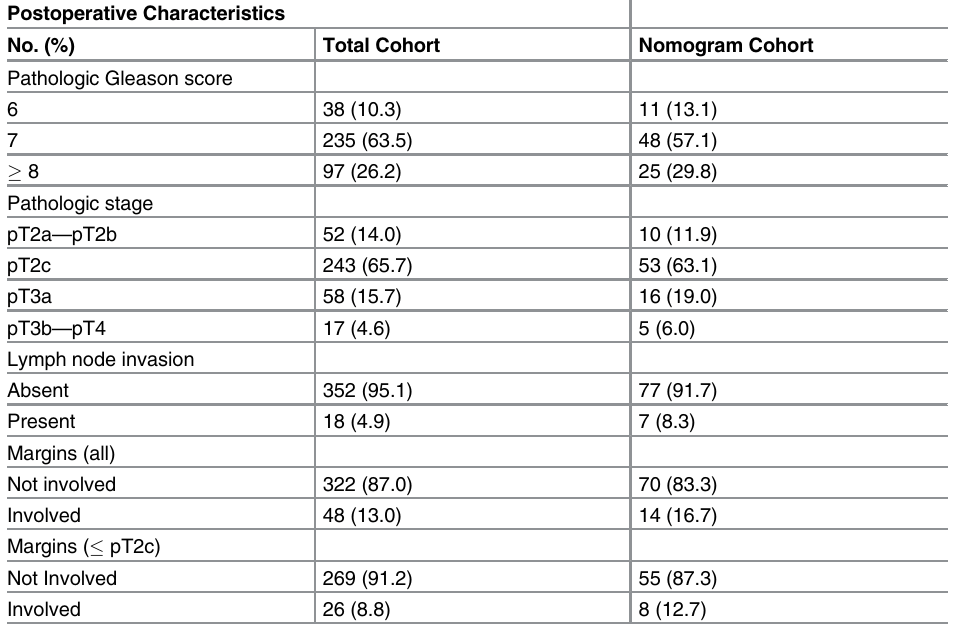
Table 2. Postoperative pathologic patient characteristics of patients undergoing radical prostatectomy.